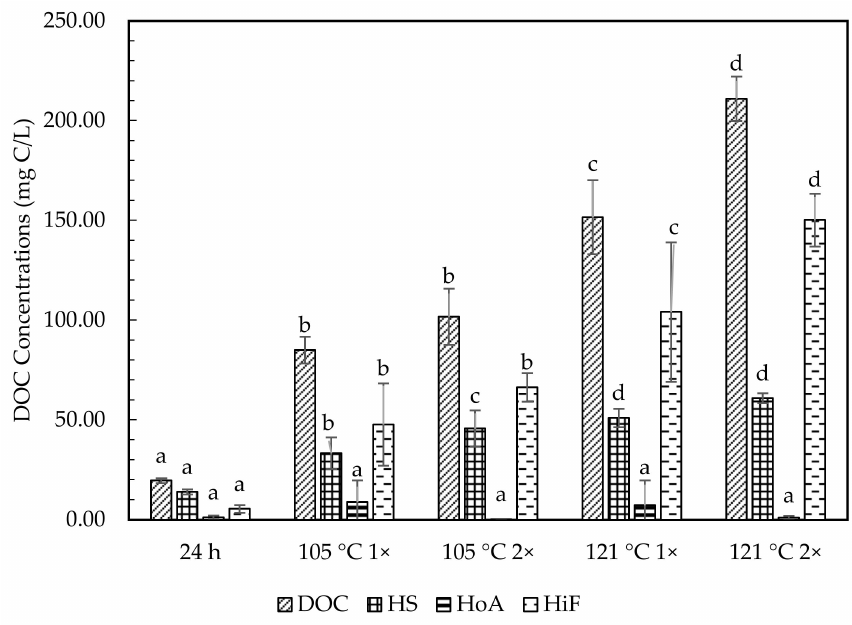
Figure 4. Fraction of dissolved organic matter for Langkawi soil extracts. DOM fractions are DOC, total dissolved organic carbon; HS, humic substances; HoA; hydrophobic neutral and HiF, hydrophilic fraction. Bar represents standard error at n = 3. Same letter on top of graph indicated no significance difference using one-way ANOVA ( p > 0.05) and Tukey post hoc. Comparison between treatments;